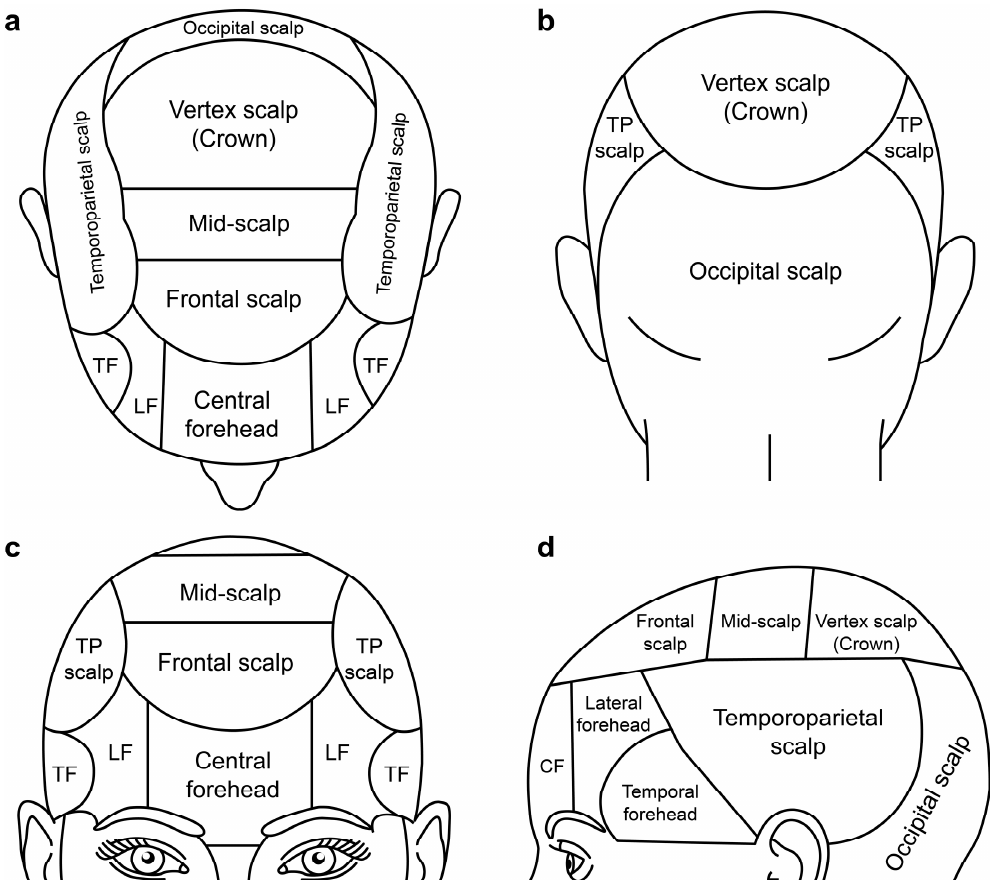
Figure 6. Schematic illustrations of anatomic regions in the scalp and forehead. ( a ) Top view of the head. ( b ) Posterior view of the head. ( c ) Anterior view of the head. ( d ) Lateral view of the head. TF, temporal forehead; LF, lateral forehead; TP, temporoparietal; CF, central forehead.